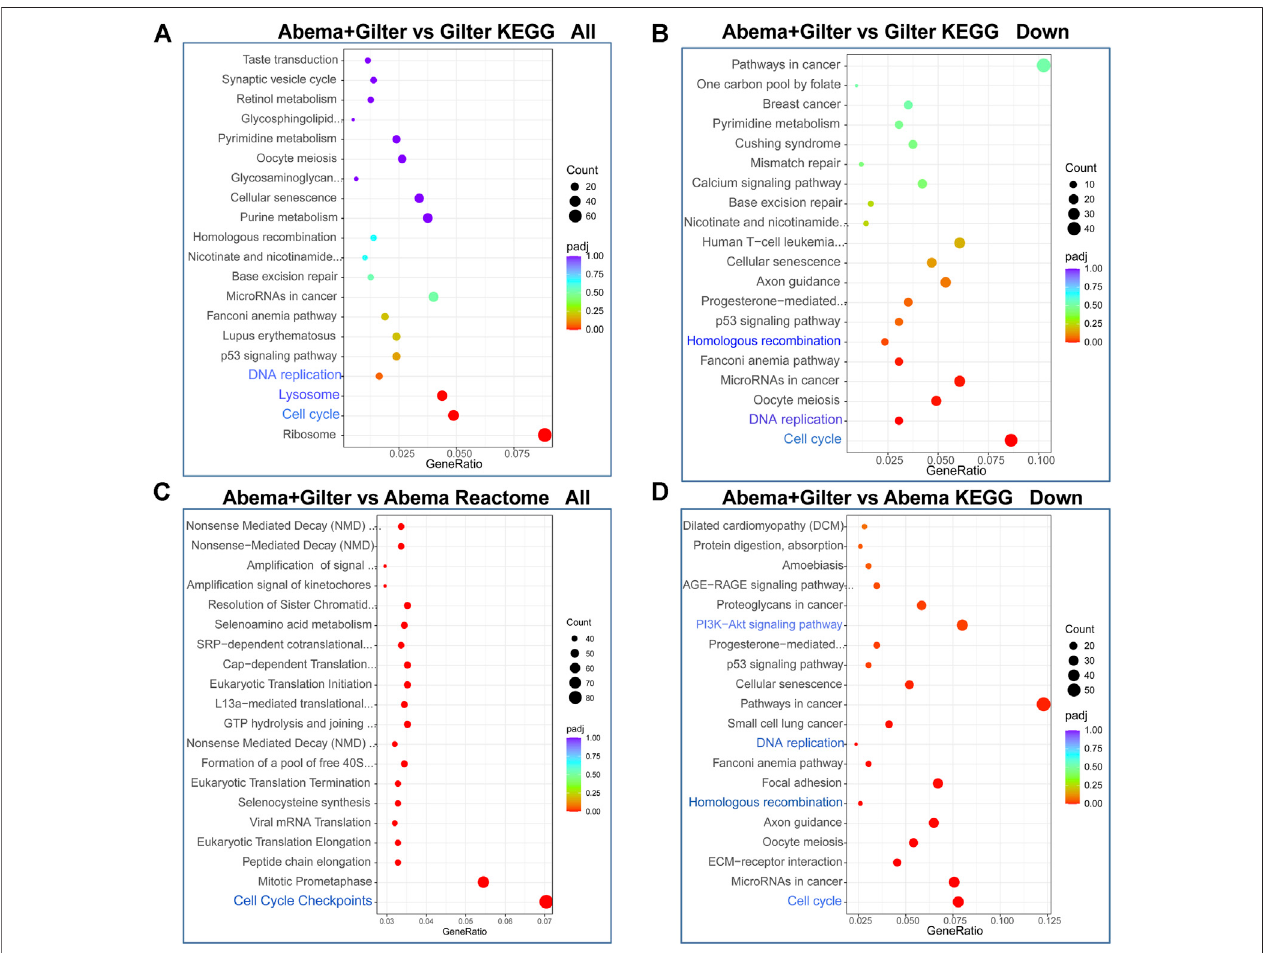
FIGURE 4 | Abemaciclib in combination with gilteritinib affects cell cycle and homologous recombination pathways. A549 cells were treated by 1 μ M abemaciclib, or 150 nM gilteritinib alone, or their combination for 48 h, the mRNA expressions were detected by RNA-seq. (A – D) Differentially expressed genes were subjected to Kyoto Encyclopedia of Genes and Genomes (KEGG) and